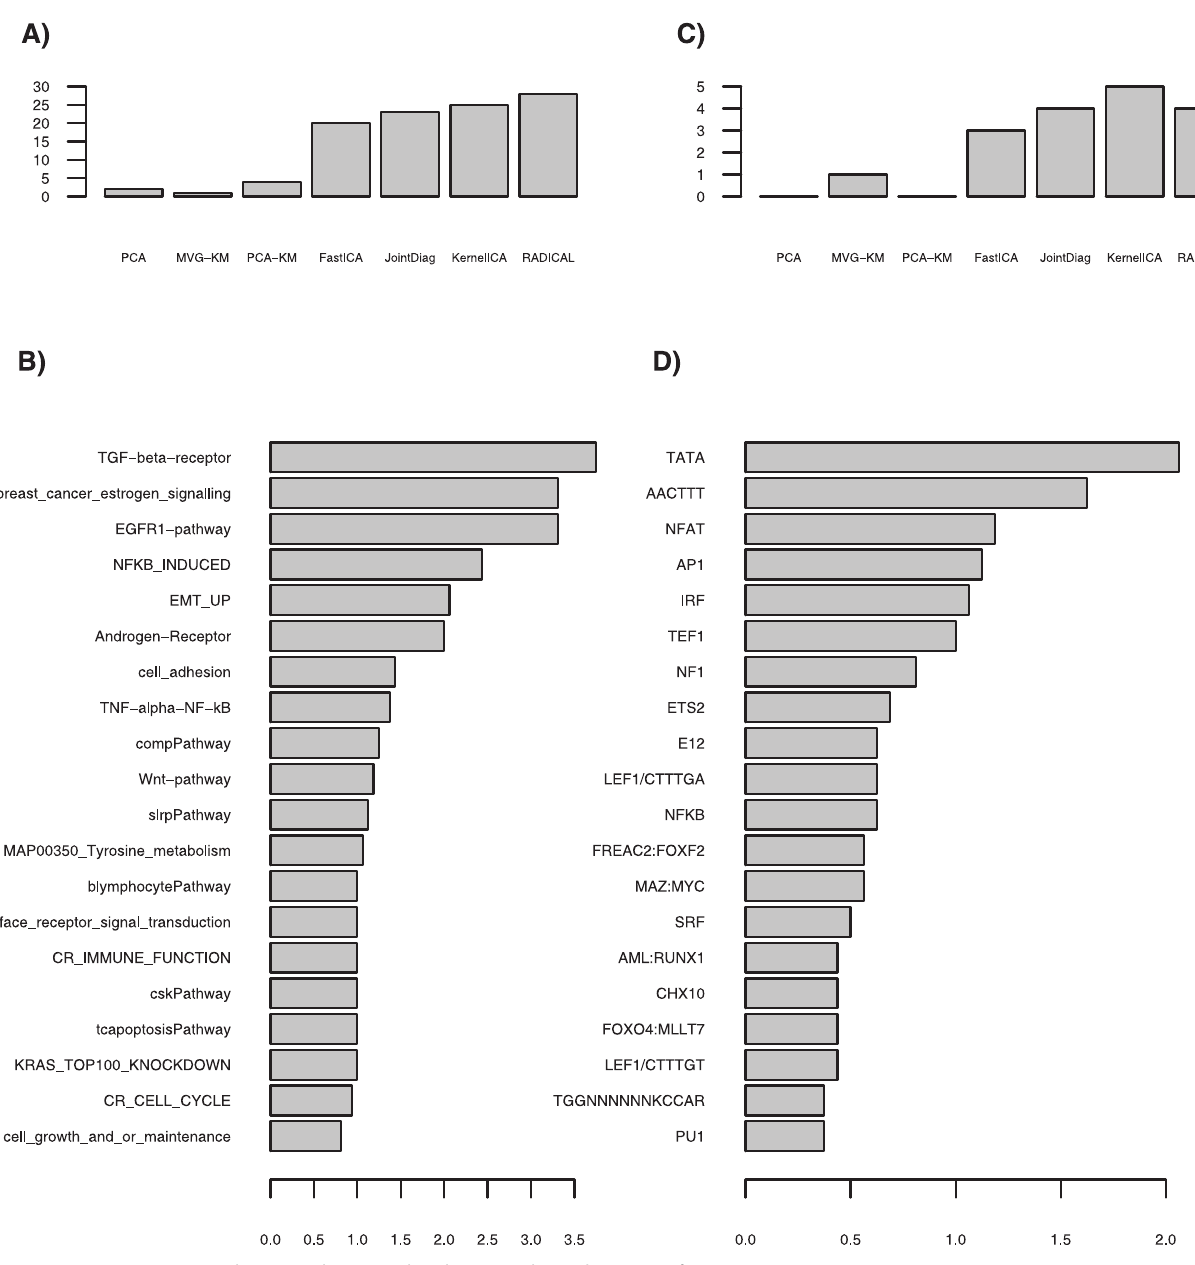
Figure 3. Most Consistent and Frequently Mapped Pathways and Regulatory Motifs (A) For each method, we compare the number of pathways that were consistently mapped to components across the four major breast cancer studies. (B) Twenty of the most frequently mapped pathways by ICA. The scores give the average number of ICA components in which the pathway was mapped. (C) For each method, we give the number of motif-regulatory gene sets consistently mapped to components across the four major breast cancer cohorts. (D) The 20 most frequently mapped transcription factors/regulatory motifs by ICA. The scores give the average number of ICA components in which the regulatory module of the motif was